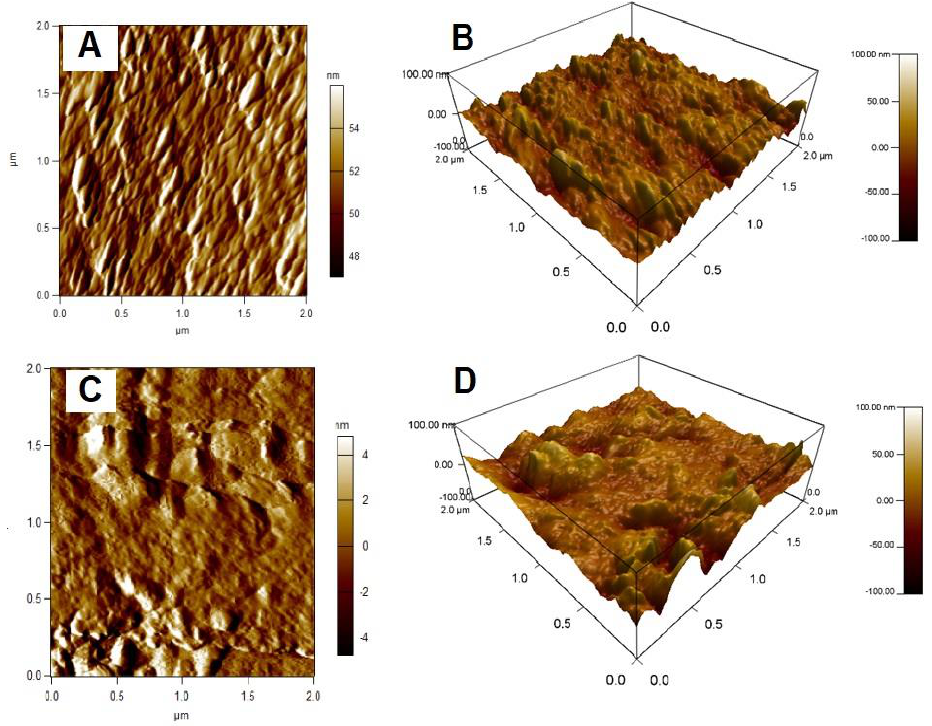
Figure 5. Atomic force microscopy (AFM) images ( A , C ) amplitude retrace mode and ( B , D ) 3D images of SA and SAHA aerogels, respectively. Table 1. Brunauer-Emmett-Teller (BET) surface area, pore size, and pore volume of the aerogels.